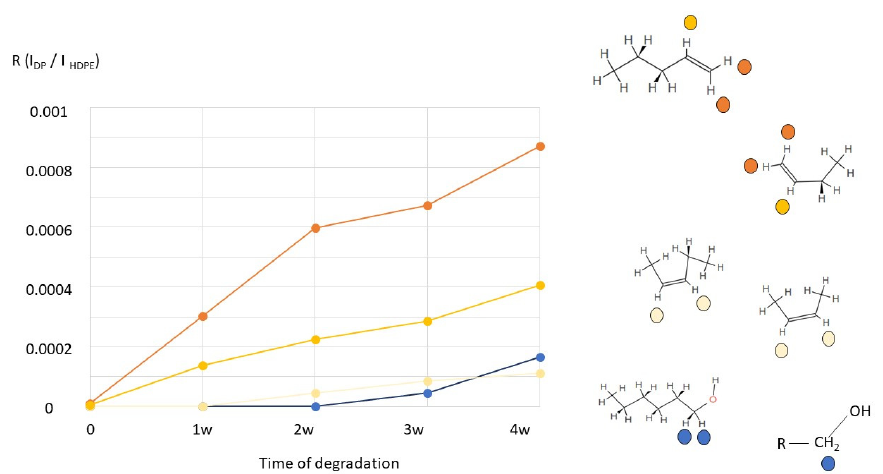
Figure 10. On the left, trends of the ratio R between the integral of the CH 2 - signals of HDPE (I HDPE ) and the integral of the signals of degradation products (I DP ), during the degradation time, from 0 (t 0 ) to 4 weeks (t 0 + 4 w). Four most significant signals have been selected, ascribable to alkene and alcohol products of degradation. On the right, molecular structure of representative molecules and proton signals under observation, as identified from 1 H NMR.